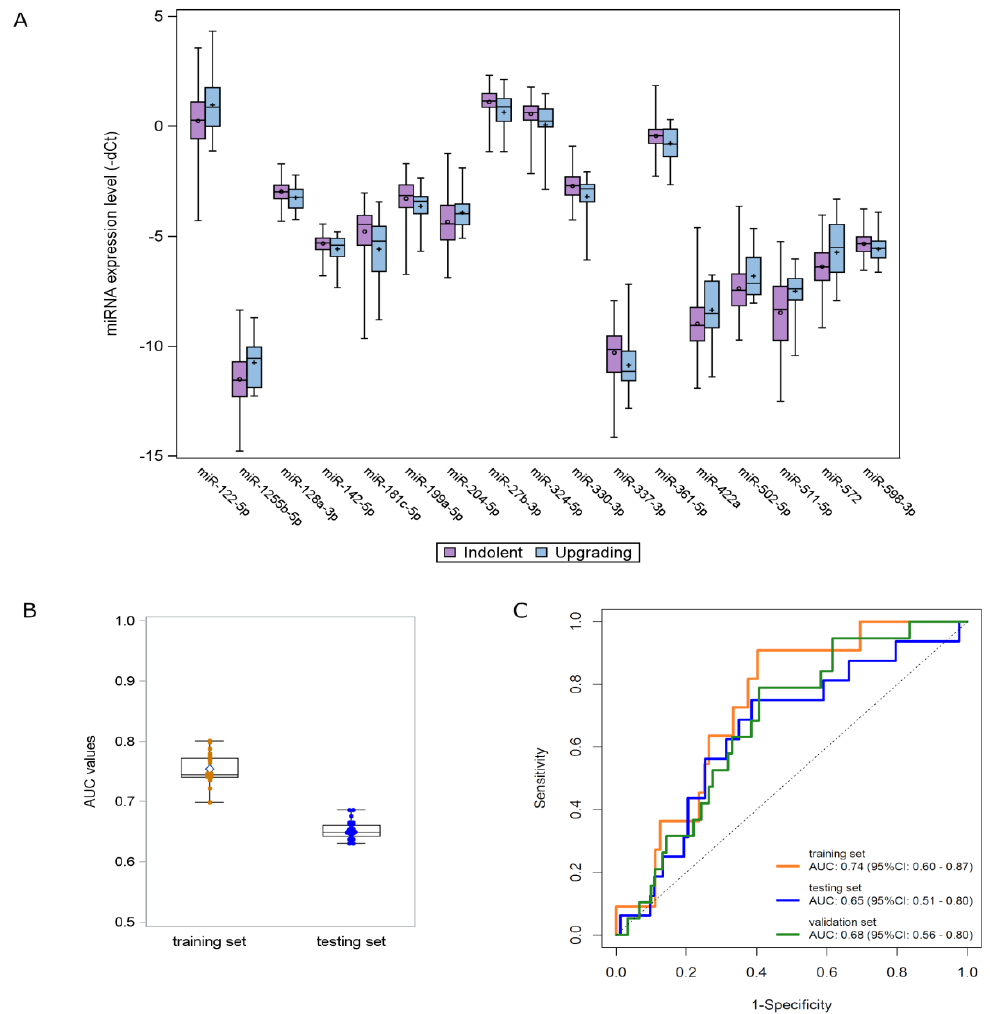
Figure 2. miRNA signature development and validation. ( A ) Distribution of the expression levels of the 17 deregulated miRNAs according to the upgrading (light blue) and indolent (purple) status found in the TRS. Each box indicates the 25th and 75th percentiles. The horizontal line inside the box indicates the median, and whiskers indicate the extreme measured values. ( B ) Box plots showing the distribution of AUC values of the 31 signatures identified in the TRS and validated in the TES. Each box indicates the 25th and 75th percentiles. The horizontal line inside the box indicates the median, and whiskers indicate the extreme measured values. ( C ) ROC curves of the 3-miRNA signature in the three AS patient cohorts: TRS (orange line), TES (blue line) and VAS (green line). Table 2. List of 17 hemolysis-free candidate miRNAs from univariate analysis on training set.